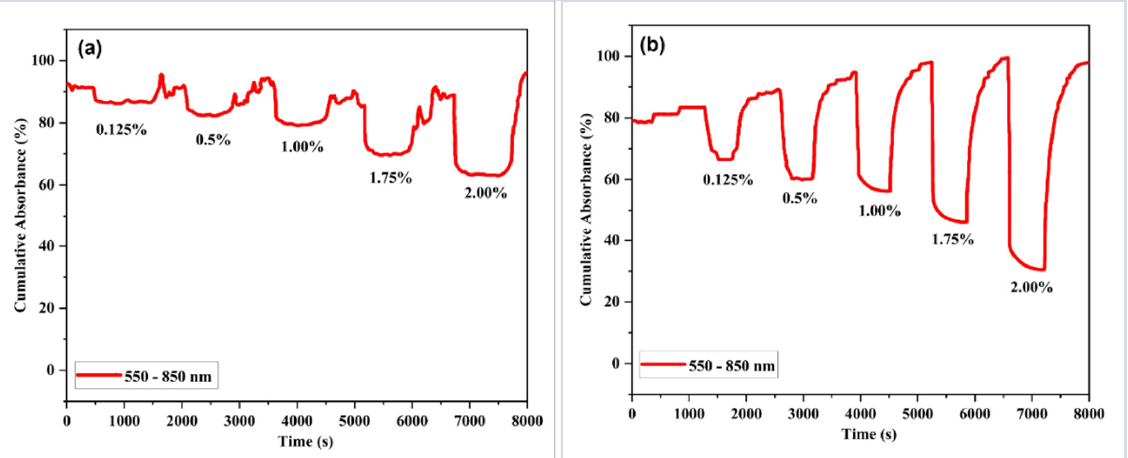
Figure 16. Dynamic absorbance curves of sensors coated with ( a ) GO and ( b ) Pd/GO nanocomposite to different H 2 concentrations in synthetic air at 100 °C.